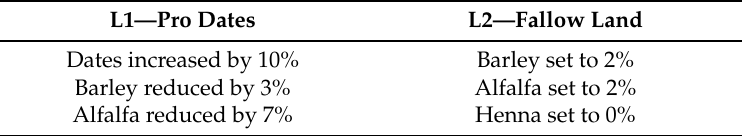
Table 3. Modified agricultural areas for the land use sub-scenarios